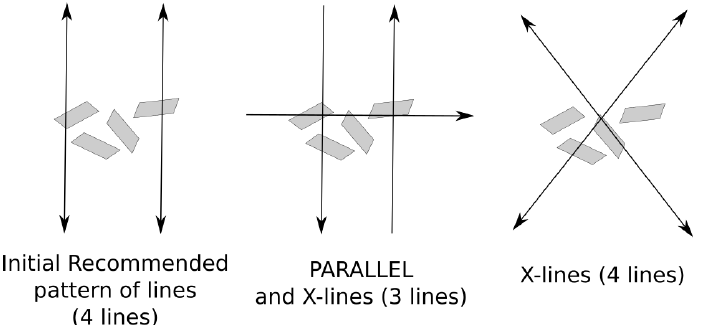
Figure 5. Potential pattern of survey lines for boresight angles